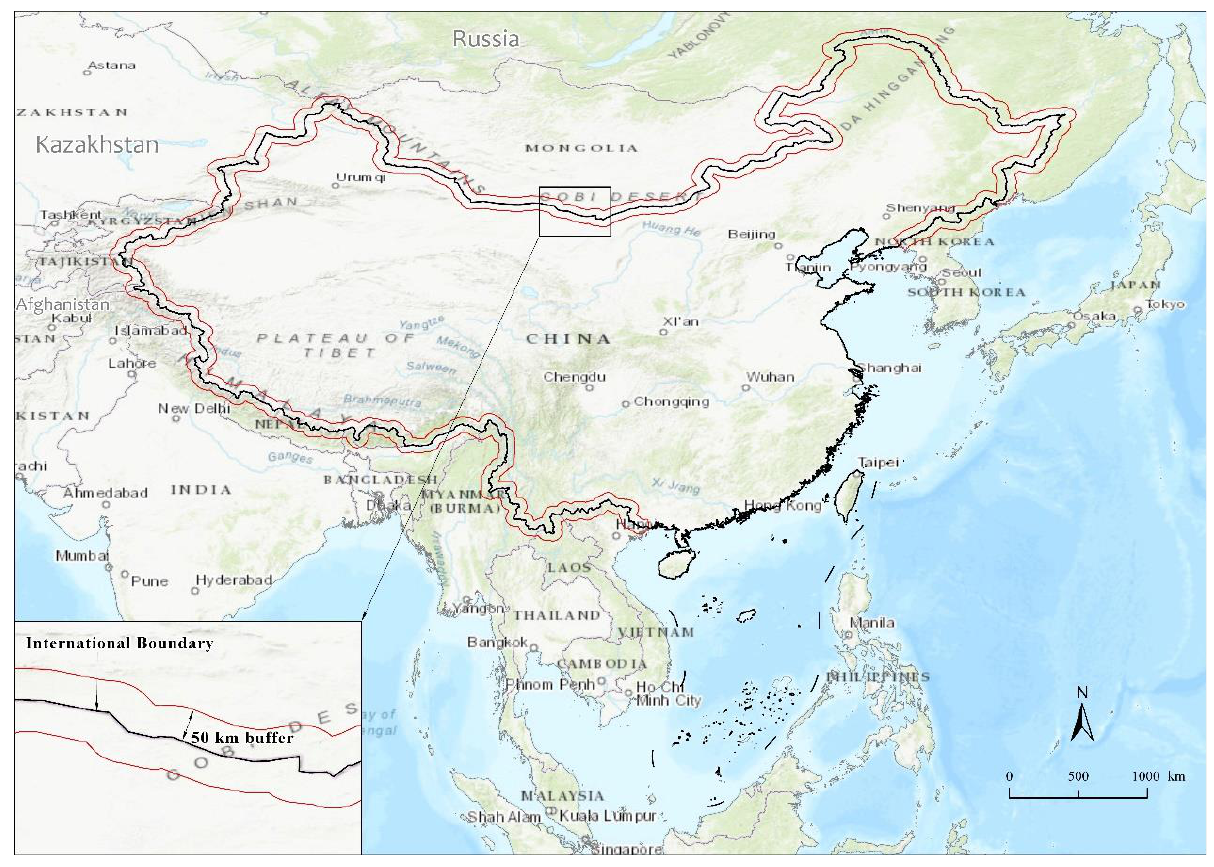
Figure 1. Study area. Table 1. Land cover datasets and sub-HAI